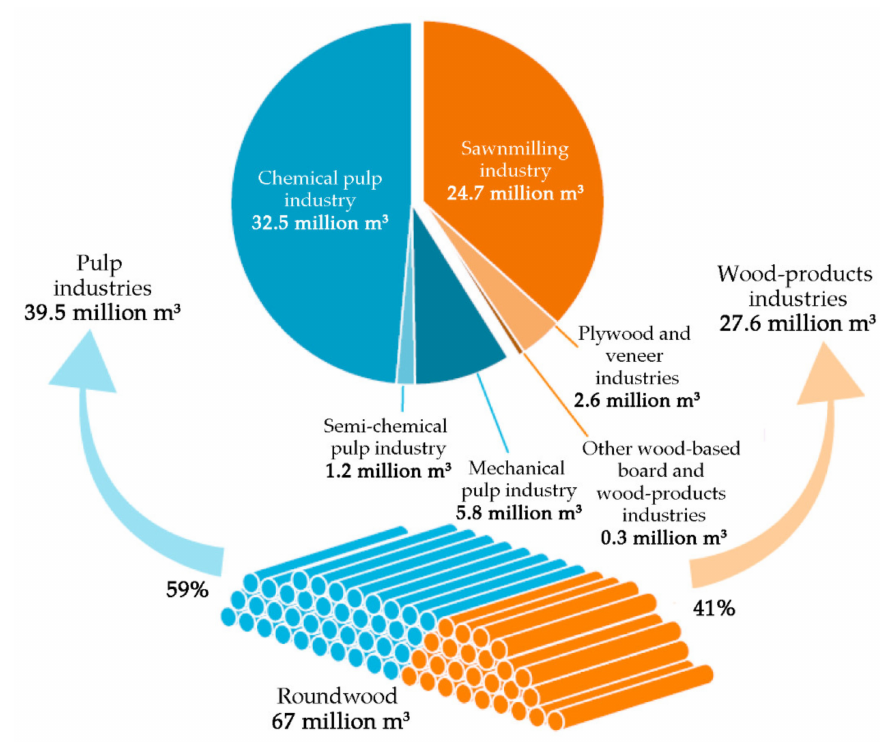
Figure 4. Use of wood in Finland.